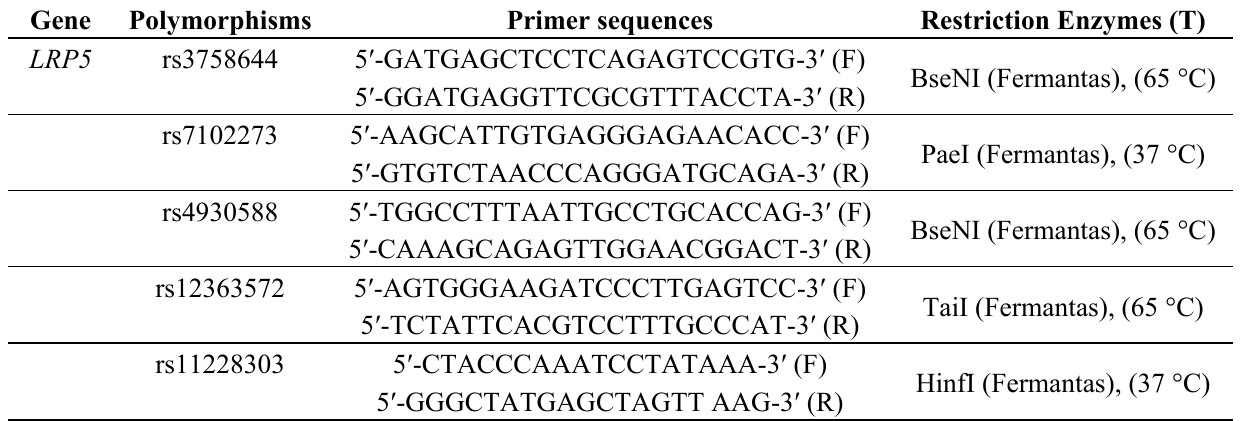
Table 15. Primer sequences and restriction enzymes for